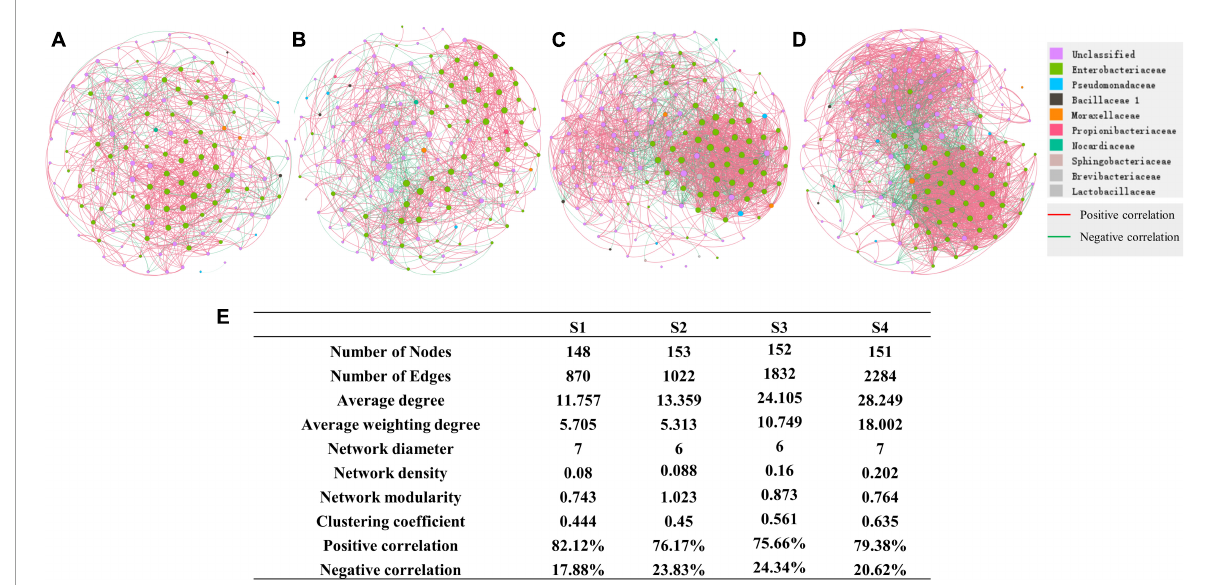
FIGURE7 Network of different sites (A) Network of bacterial community at S1. (B) Network of S2. (C) Network of S3. (D) Network of S4. (E) Details of networks in different